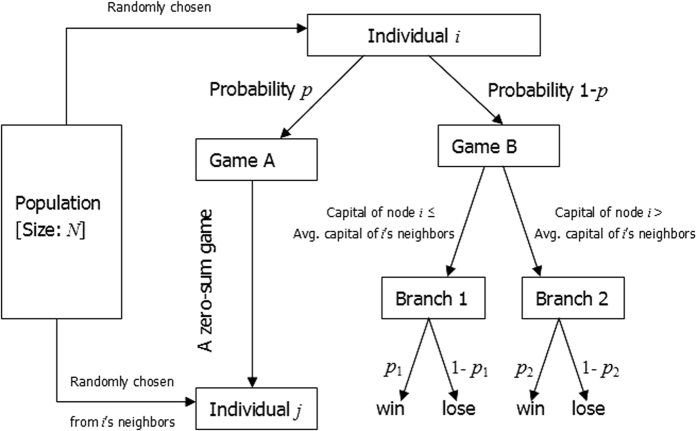
The multi-agent Parrondo’s model based on complex networks12.